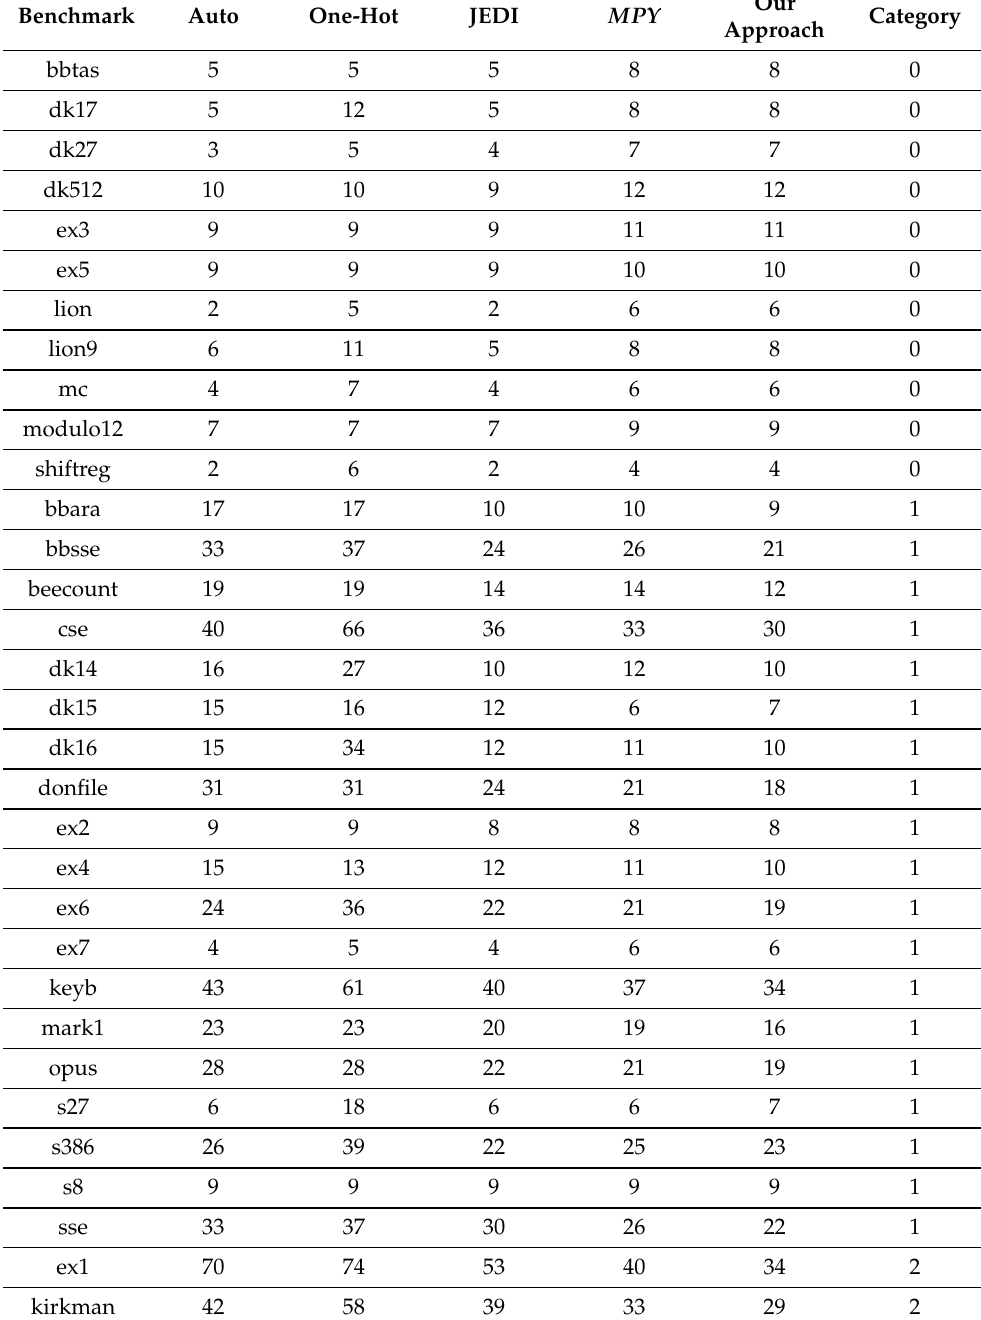
Table 8. Experimental results (LUT